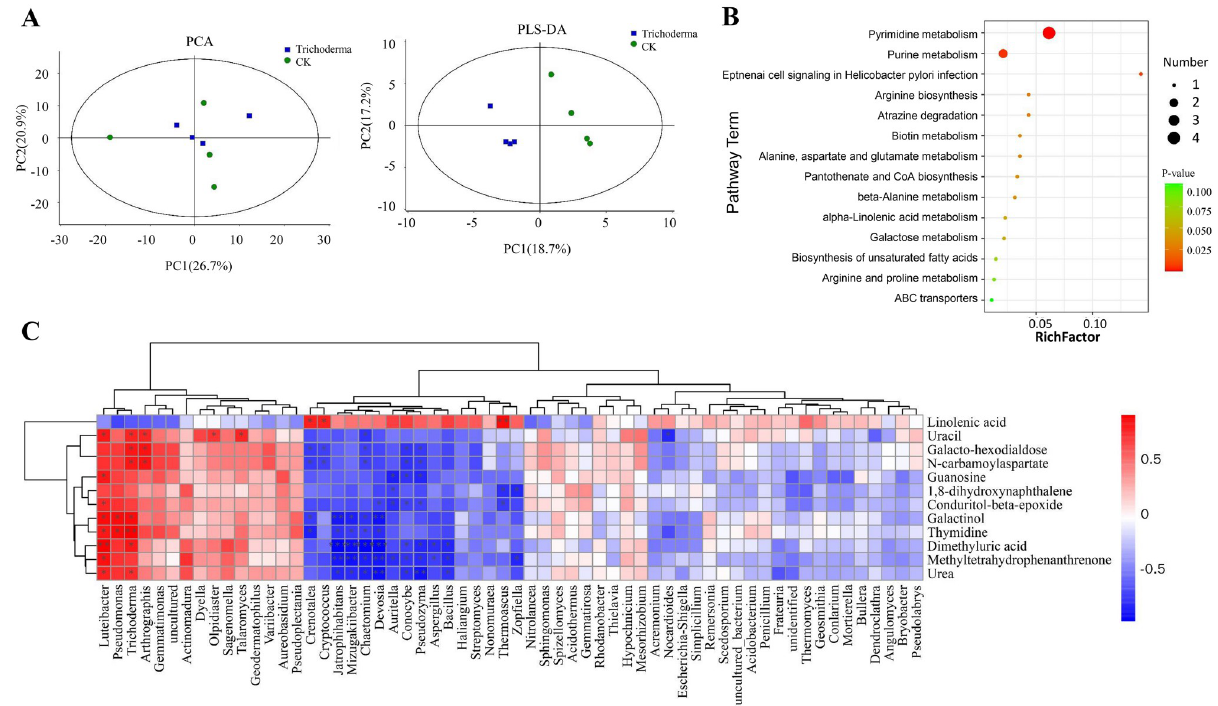
Fig 6. Effect of T . asperellum M45a inoculation on the activities of soil metabolites. A: PCA and PLS-DA between the M45a treatment and CK; B: KEGG enrichment of the differential metabolites of soils; C: Heatmap of the correlation between differential metabolites and differential microorganisms ( � P < 0.05; �� P <